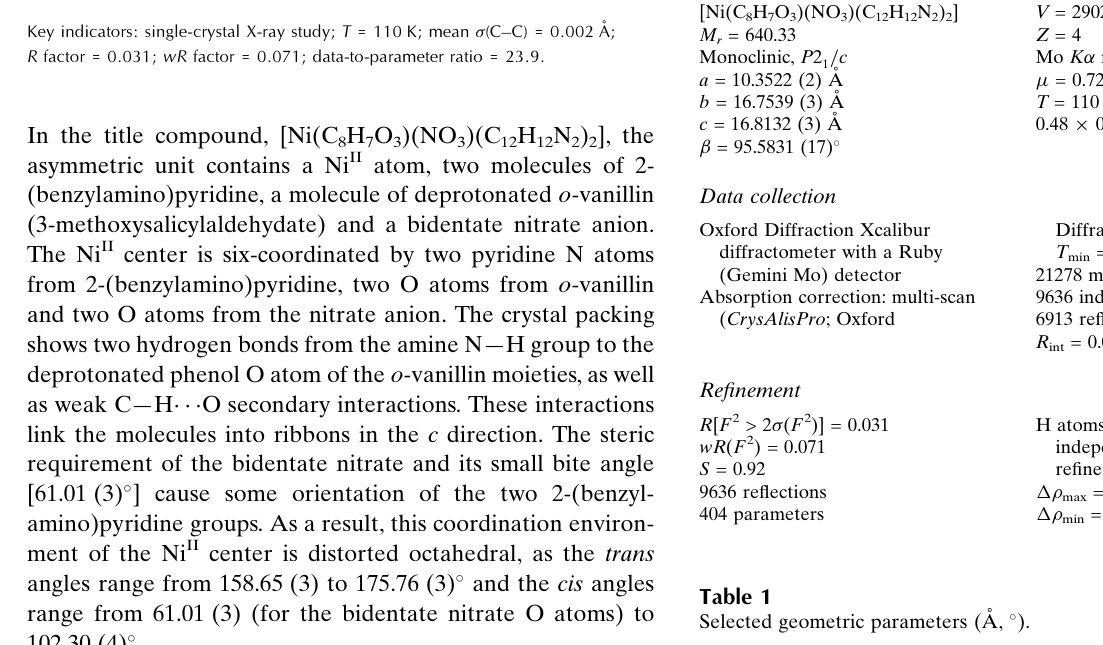
Diffraction, 2009) T min = 0.724, T max = 0.861